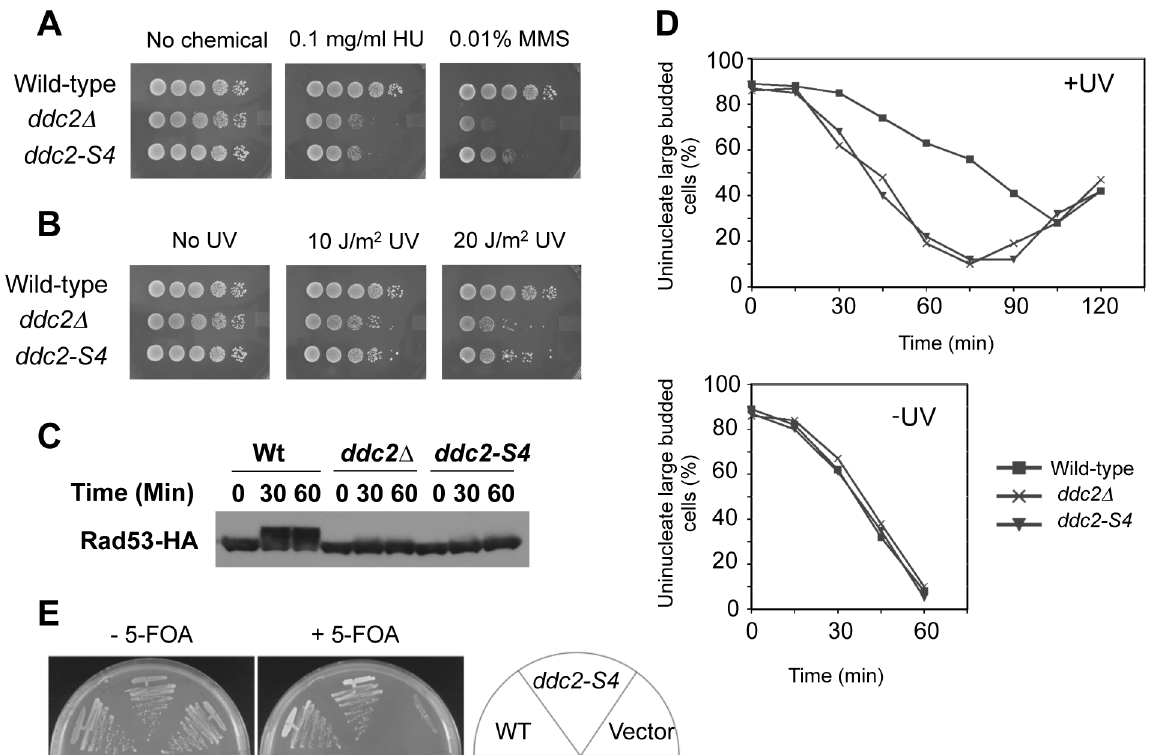
Figure 3. DNA damage response and proliferation of ddc2-S4 mutants. (A, B) DNA damage sensitivity of ddc2-S4 mutants. Serial dilutions of cultures were spotted on YEPD medium without or with MMS or HU (A). Cultures spotted on YEPD medium were irradiated with UV light (B). Plates were incubated at 30 u C for two-three days. Strains used were wild-type (KSC1178), ddc2 D (KSC1234) and ddc2-S4 (KSC3153). (C) Effect of ddc2-S4 on DNA damage checkpoint signaling. Wild-type (KSC1178), ddc2 D (KSC1234), and ddc2-S4 (KSC3153) cells expressing Rad53-HA were grown to log- phase and exposed to MMS (0.05%) at 30 u C for the indicated length of time. Cells were harvested and subjected to immunoblotting analysis with anti-HA antibodies. (D) G2/M-phase DNA damage checkpoint in ddc2-S4 mutants. Wild-type (KSC1178), ddc2 D (KSC1234) or ddc2-S4 (KSC3153) cells were arrested with nocodazole and irradiated or not irradiated with UV (50 J/m 2 ). At the indicated times after release of UV-irradiated ( + UV) and unirradiated ( 2 UV) cultures from nocodazole, the percentage of uninucleate large budded cells was scored by DAPI staining. (E) Effect of ddc2-S4 mutation on cell proliferation in the presence of SML1 . ddc2 D mutants carrying the URA3 -marked YCp-DDC2 plasmid (KSC3308) were transformed with YCpT-DDC2, YCpT-DDC2-S4 or the control vector. Transformants were streaked and grown on plates containing medium with or without 5- fluoroorotic acid (5-FOA) at 30 u C. Only cells that have lost the URA3 -marker plasmid can proliferate in the presence of 5-FOA [62].